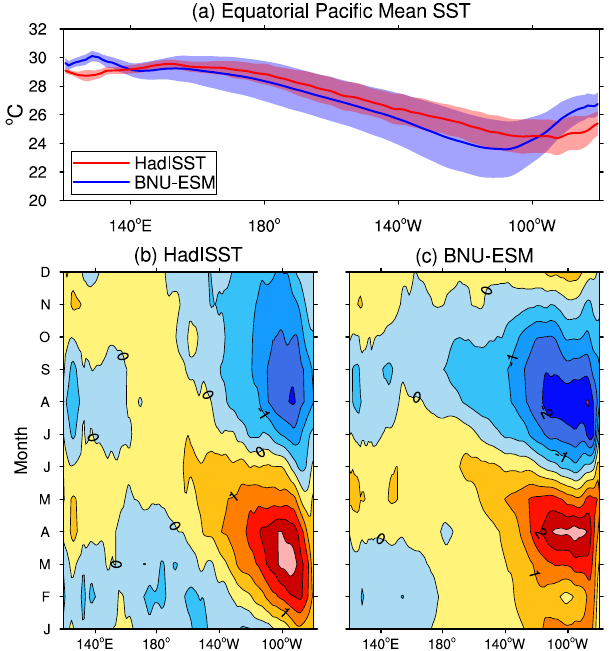
Figure 11. Mean SST ( ◦ C) along the equator in the Pacific Ocean (a) , color shading indicates interannual variability (standard deviation). Annual cycle of SST anomalies for the period 1976– 2005 from HadISST (b) and the BNU-ESM historical run (c) .